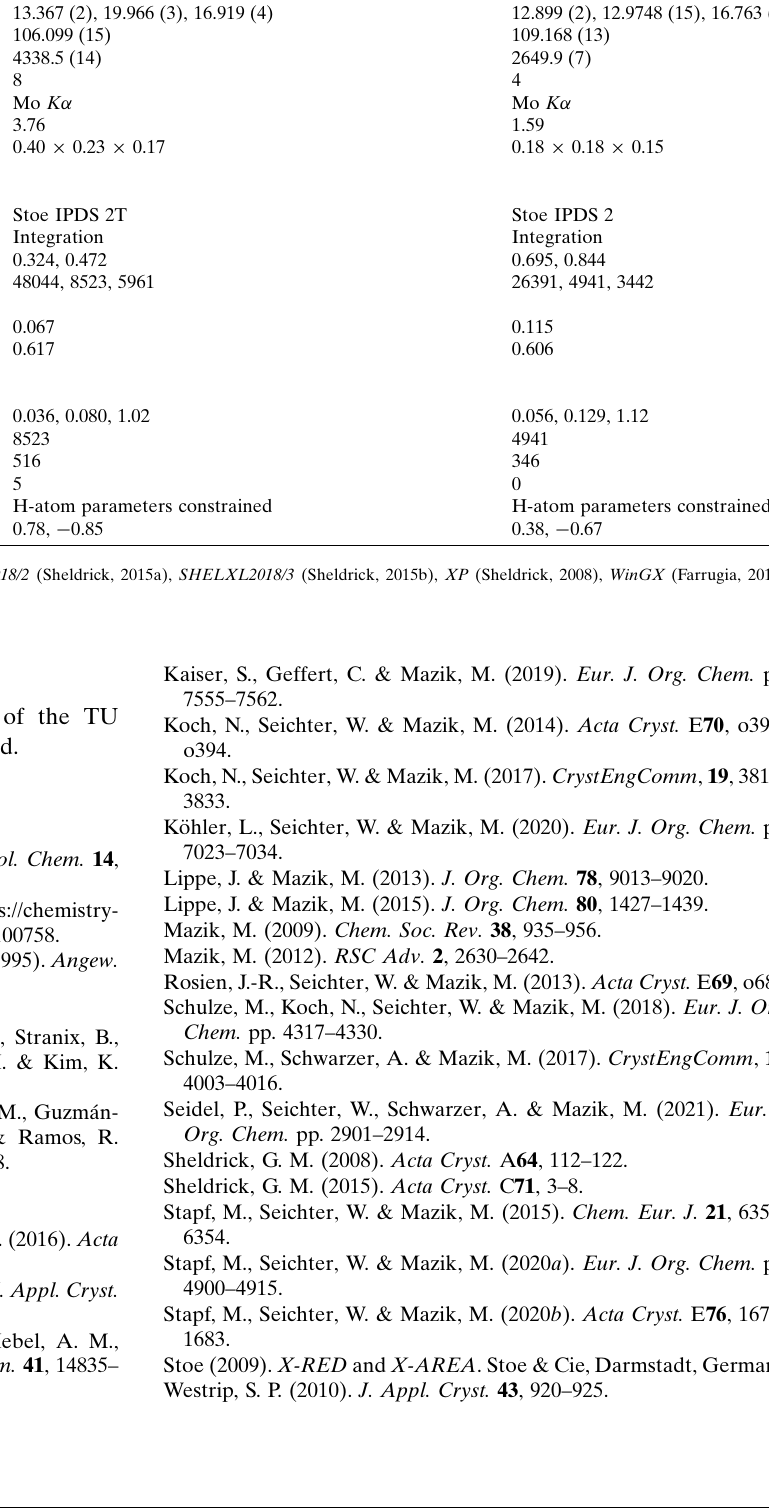
Crystal data Chemical